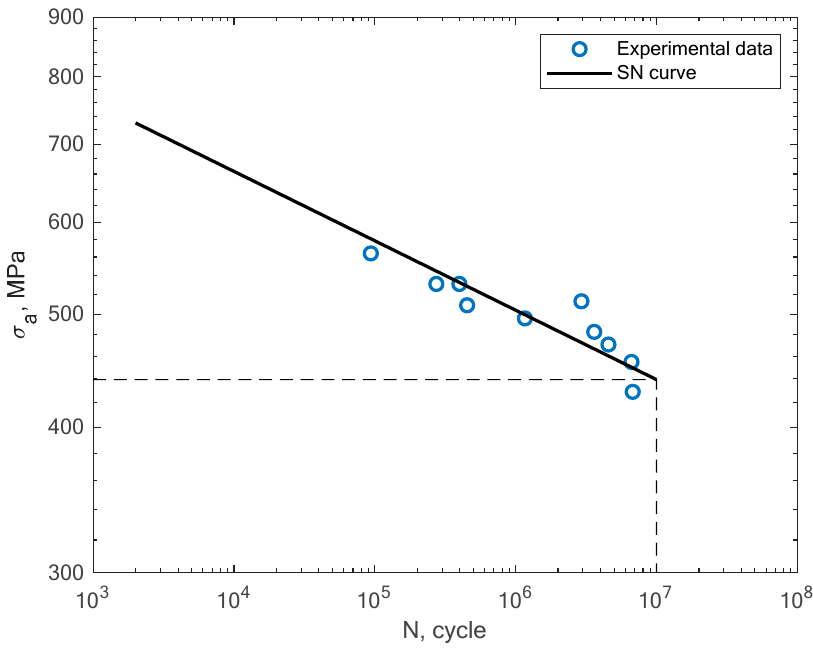
Figure 13. S–N curve for the experimental bending fatigue test results reported by Kostic et al. [2] for the case of no heat treatment and machining.